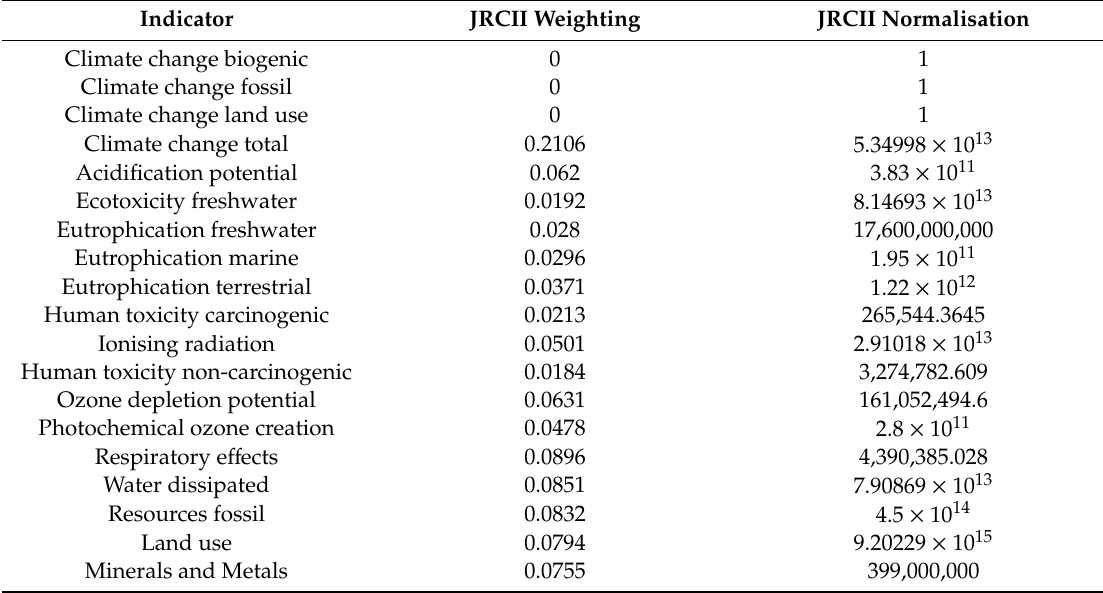
Table A1. JRC weighting and normalisation factors (taken from